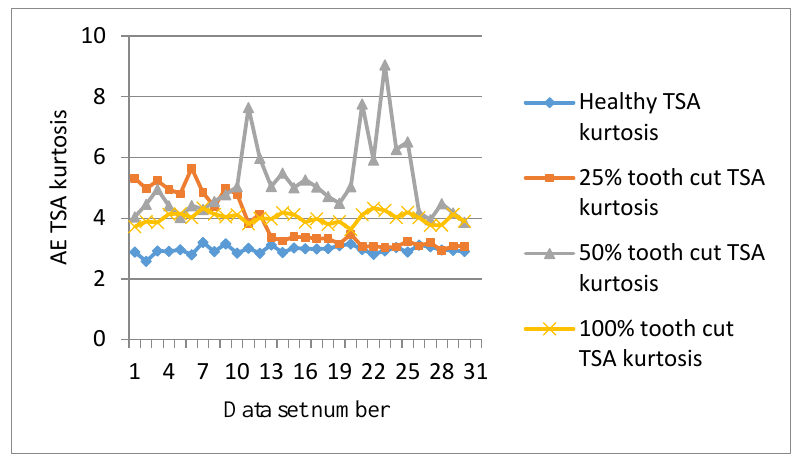
Figure 10. Kurtosis of AE TSA signals.